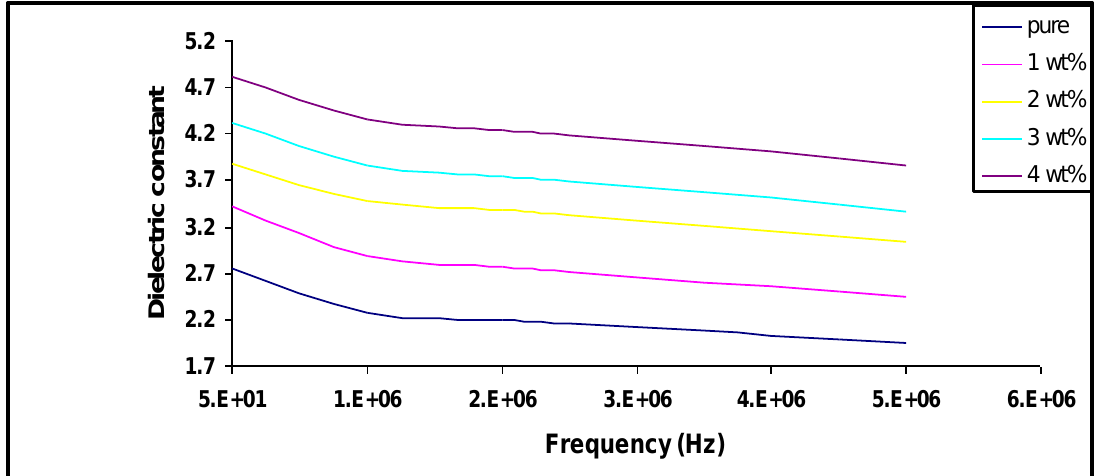
Fig.1 : The variation of the dielectric constant of (PVA-NaI) composites with angular frequency.